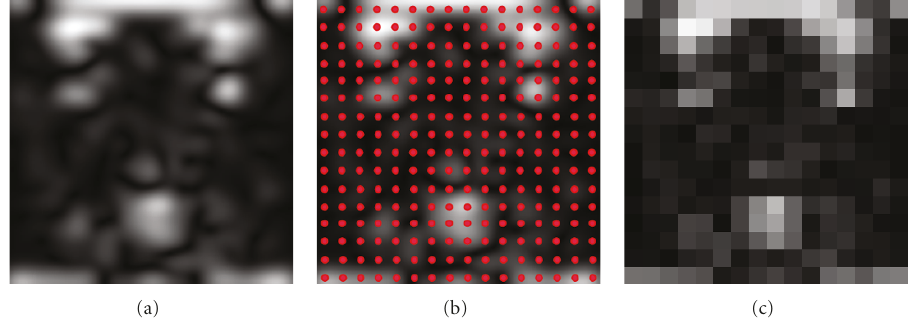
Figure 4: Down-sampling of a magnitude filter response with a rectangular sampling grid (from left to right): (a) an example of a magnitude response, (b) an example of the magnitude response with a superimposed rectangular sampling grid, and (c) a downsampled magnitude